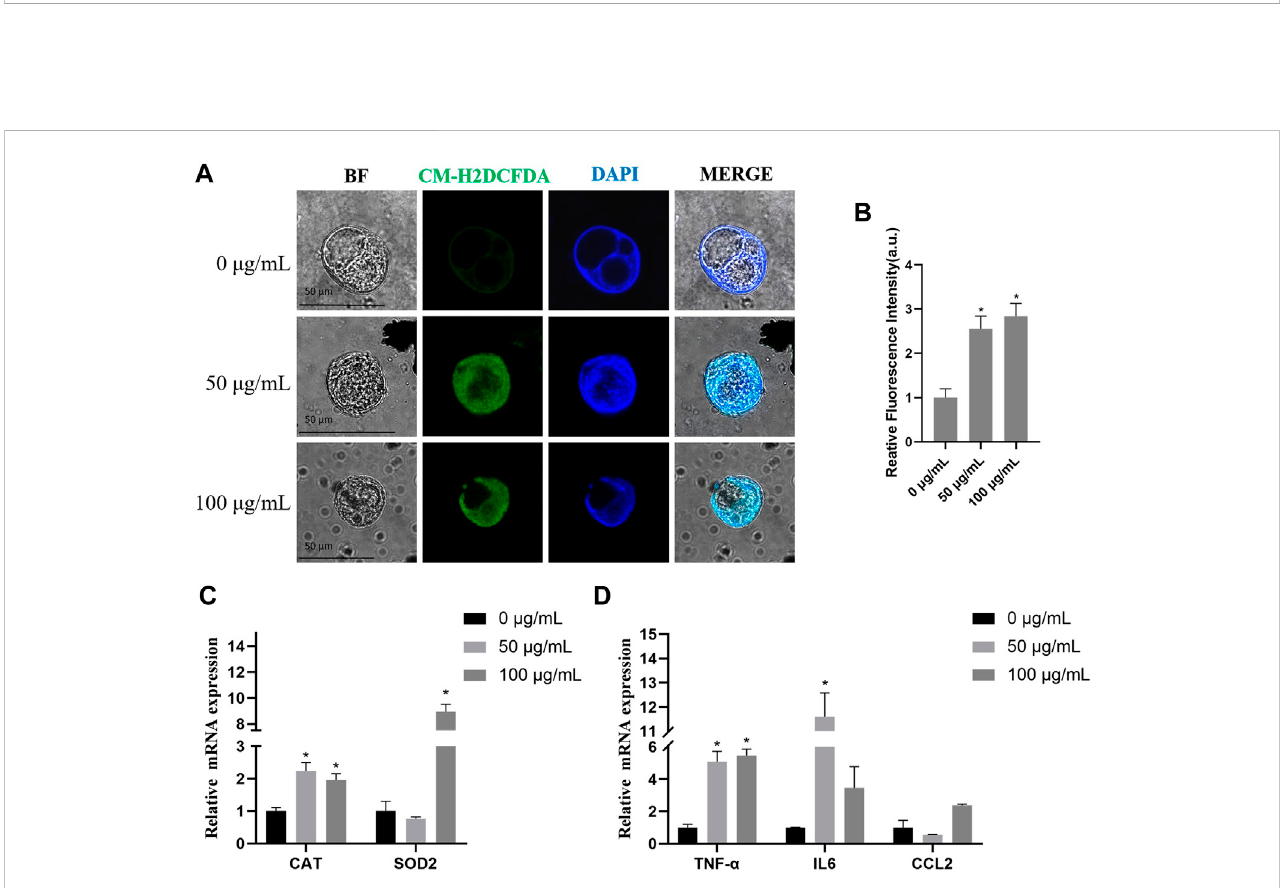
FIGURE 7 ROS generation and in fl ammation induced by TWPs in hAOs. (A,B) ROS production induced by TWPs in hAOs was detected by CM-H2DCFDA staining. Green fl uorescence and blue fl uorescence represent ROS and nuclei, respectively. Scale bar, 50 μ m. ROS levels are presented as the relative fl uorescence intensity normalized to the control. (C,D) qPCR analysis for oxidative stress-related genes and in fl ammation cytokine-related